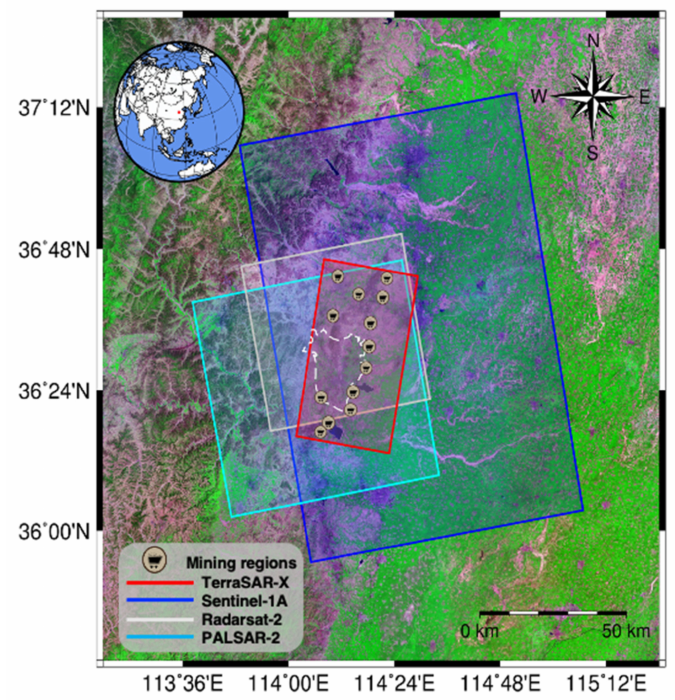
Figure 2. Coverage of SAR satellite datasets used in this study. The main mining regions are marked with symbols. The background image is a false color composite from